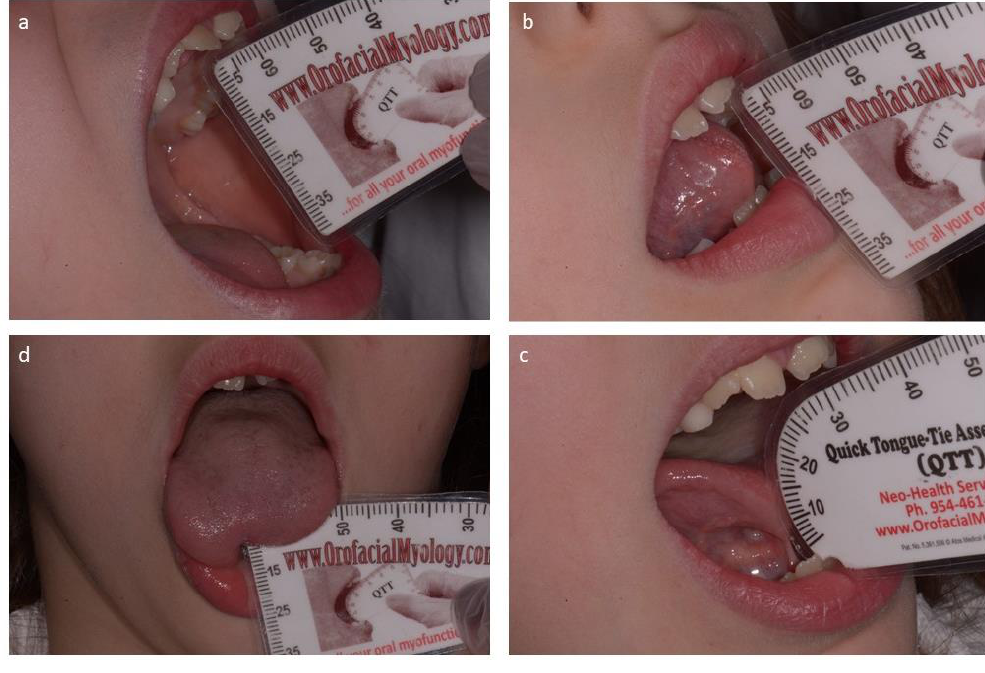
Figure 1. Quantitative evaluation at t0: ( a ) (MAB), ( b ) (MIO), ( c ) (MOTTIP), ( d ) (PROTRUSIONE).